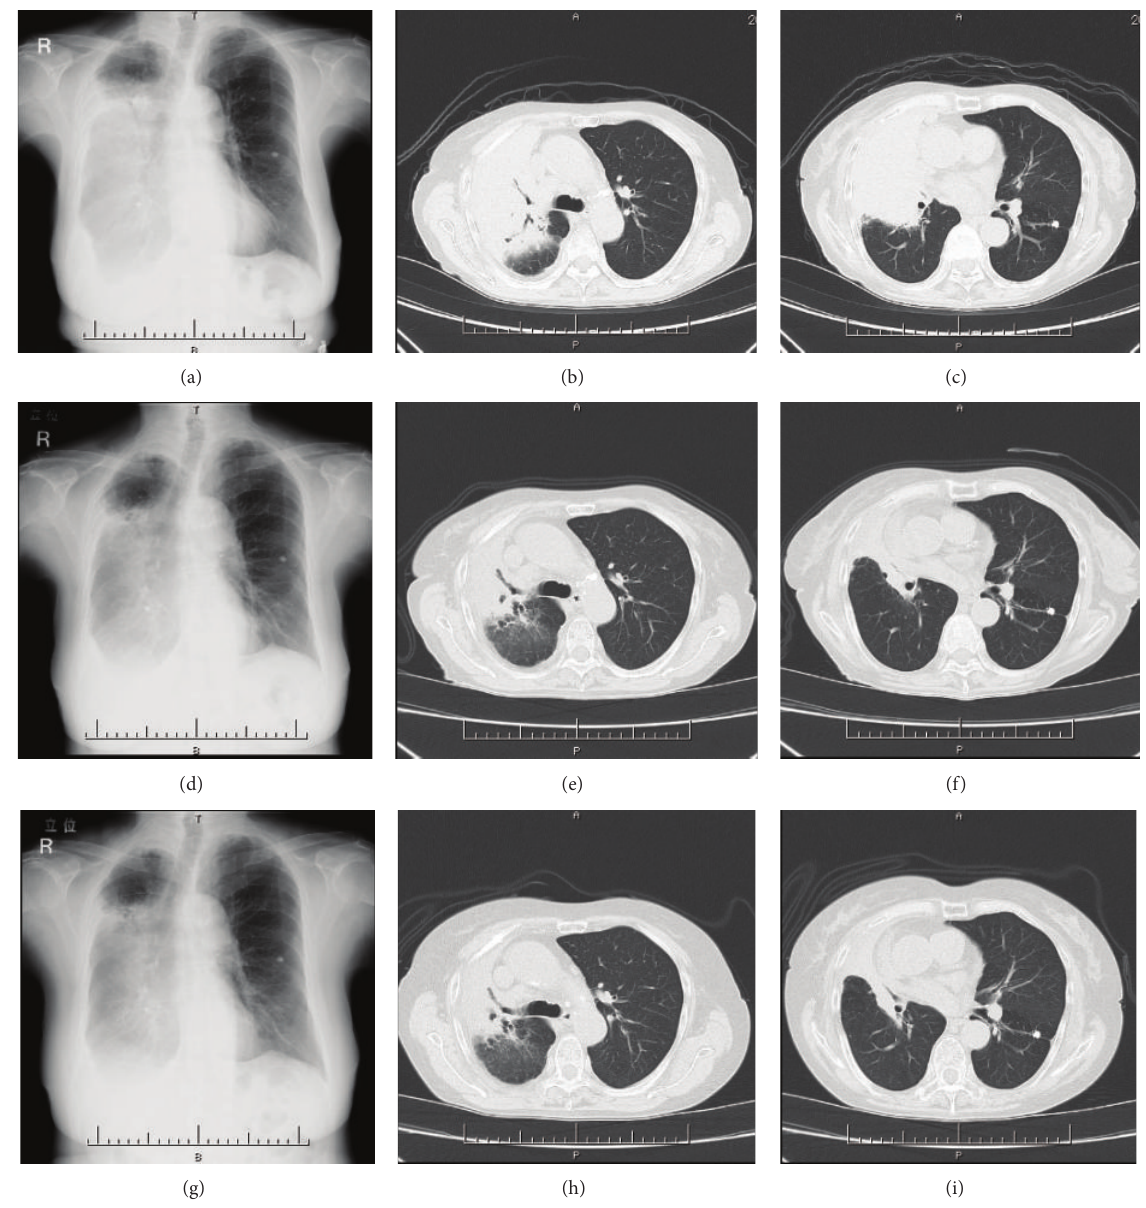
Figure 2: Chest X-ray (a) and CT scan ((b) and (c)) immediately before the administration of yttrium-90 ibritumomab tiuxetan. Chest X-ray (d) and CT ((e) and (f)) 2 months after its administration. Chest X-ray (g) and CT scan ((h) and (i)) 18 months after its administration. The abnormal shadow was significantly reduced after the administration of yttrium-90 ibritumomab tiuxetan. Radiation pneumonitis has not been reported for 18